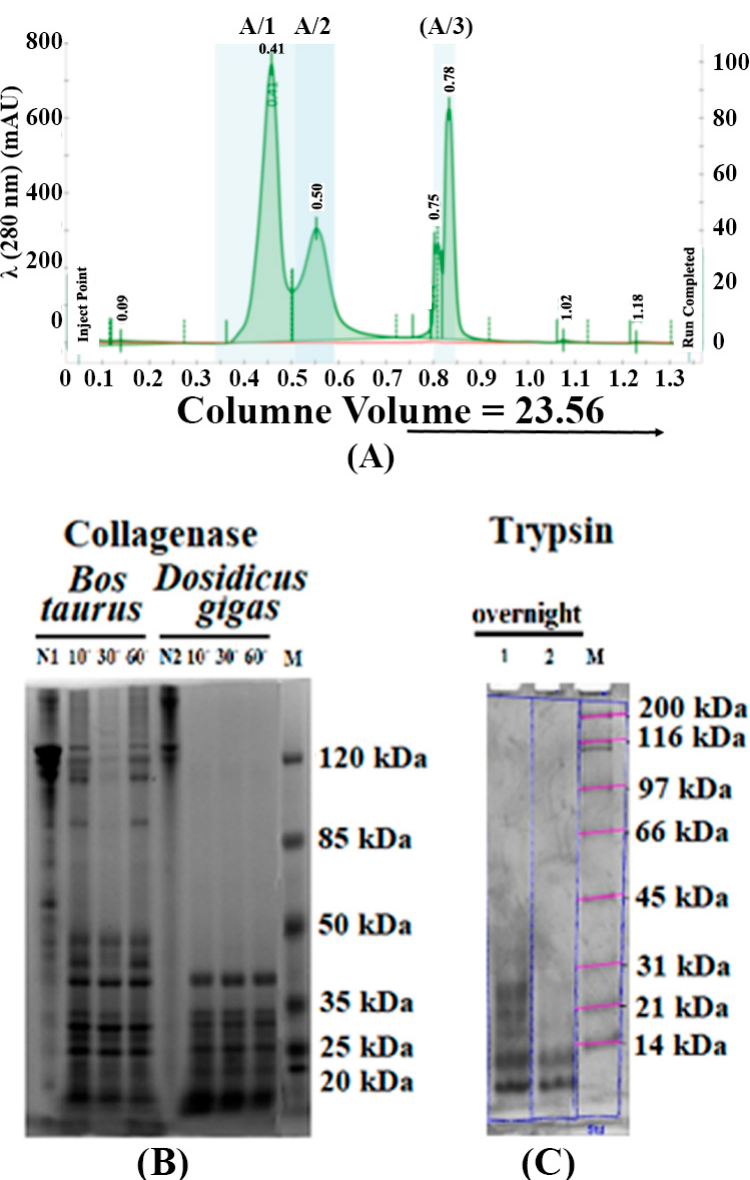
Figure 3. Results for hydrobionts collagen fractionation by SDS-PAGE in different conditions. ( A ) Size exclusion chromatography of hydrobionts collagen. ( B ) Results of hydrobionts collagen type I, II, and III fractionation by SDS-PAGE after collagenase treatment. ( C ) Results of hydrobionts collagen type I, II, and III fractionation by SDS-PAGE after trypsinolysis.